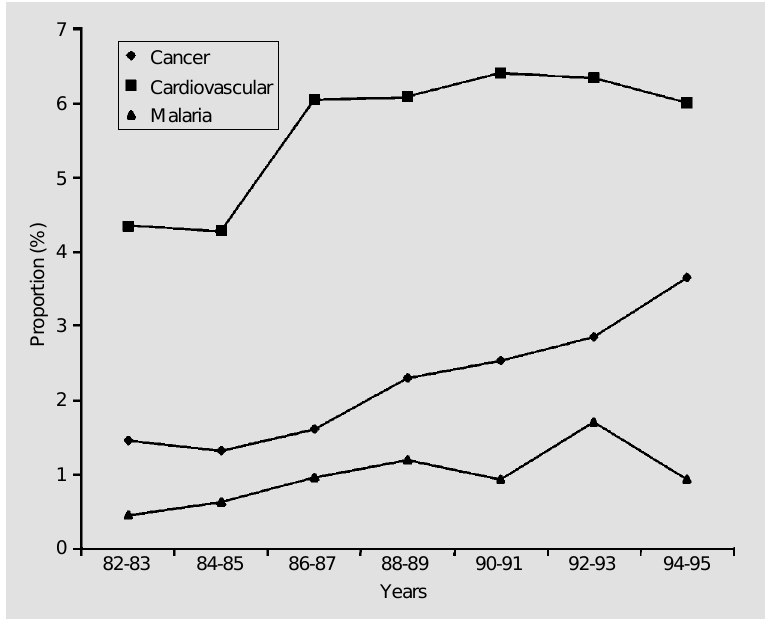
Figure 2 - Values express the proportion (%) between number of articles on cancer, cardiovascular disease and malaria (ISI data only) and the articles of life sciences as a whole. These articles included all ISI catcodes (categories of specialized or multidisciplinary jour- nals classified by the ISI; more details in Ref. 8) related to life